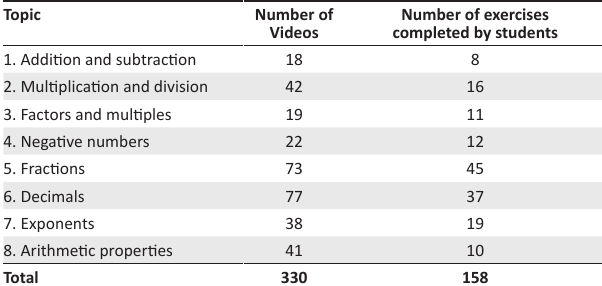
TABLE 1: Mathematics topic structure. Topic